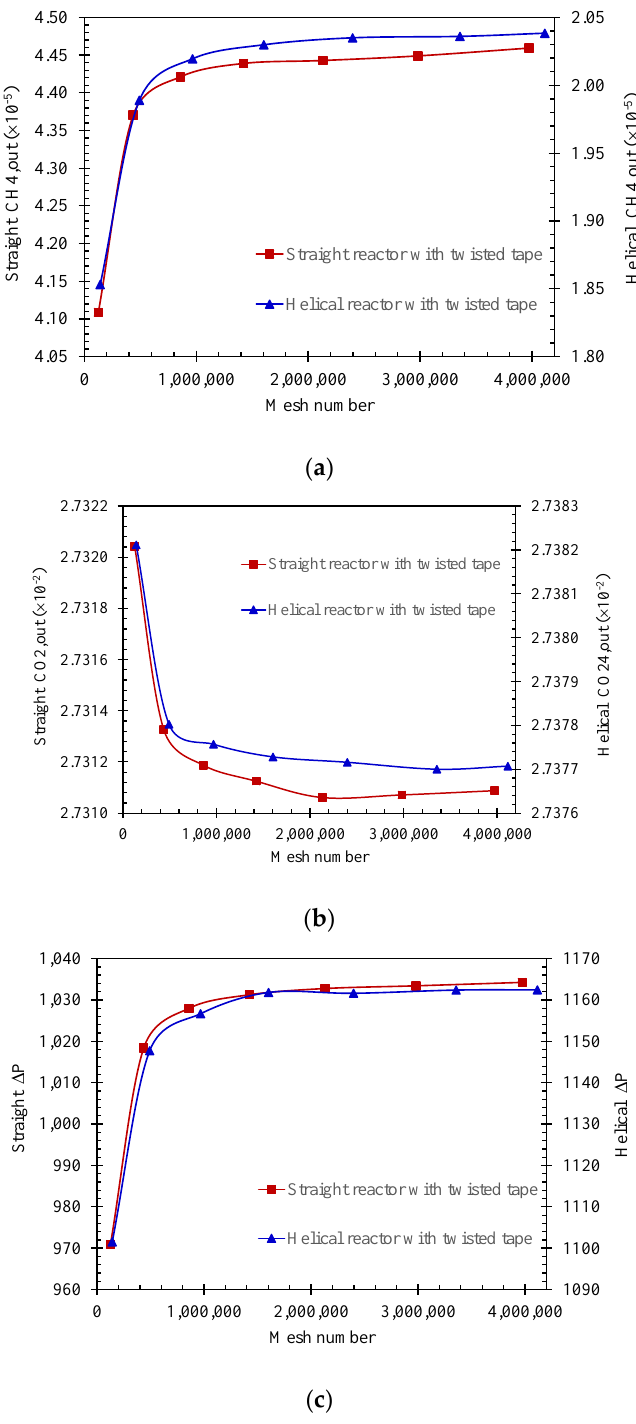
Figure 10. Mesh independent test result in term of ( a ) outlet methane concentration (kmol/m 3 ), ( b ) outlet carbon dioxide concentration (kmol/m 3 ), and ( c ) pressure drop (Pa) along the reactor channel with twisted tape insert ( y = 3.15) at Re 100 for various meshes.